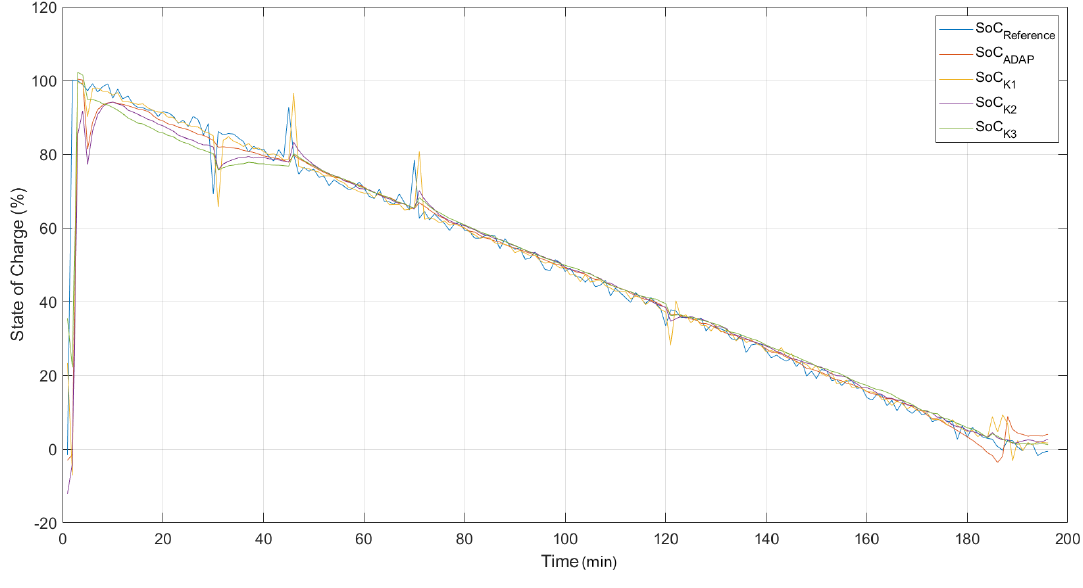
Figure 9. Validation of ANN models. State of Charge—training result with the presence of noise and outliers.